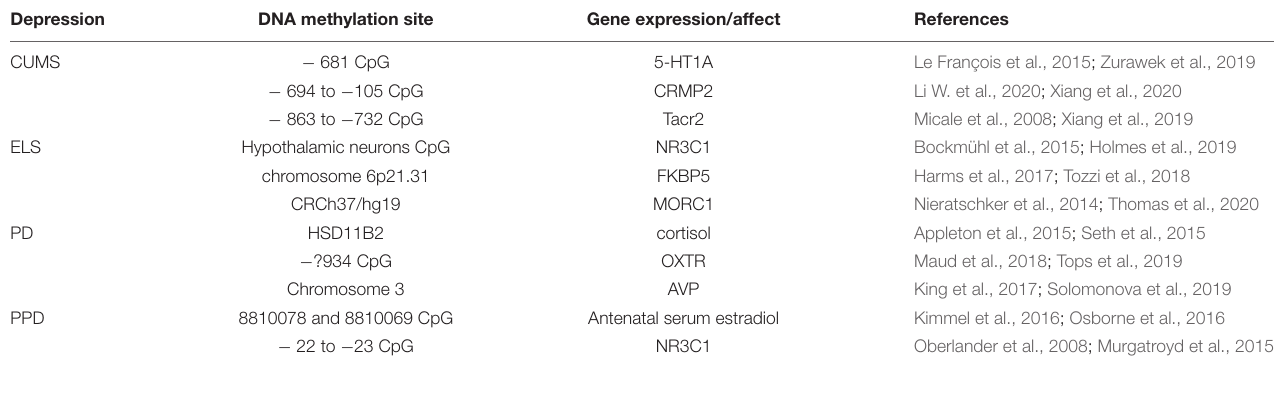
TABLE 1 | Epigenetic changes depression: related gene and expression.